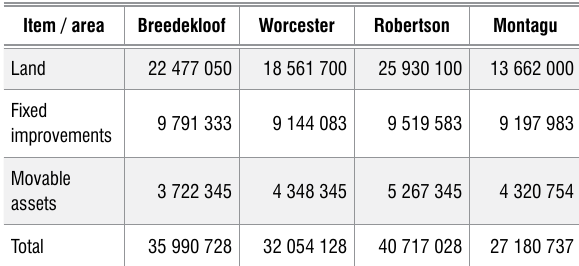
The investment requirement in rands (ZAR) for the ‘typical farm’ for each area